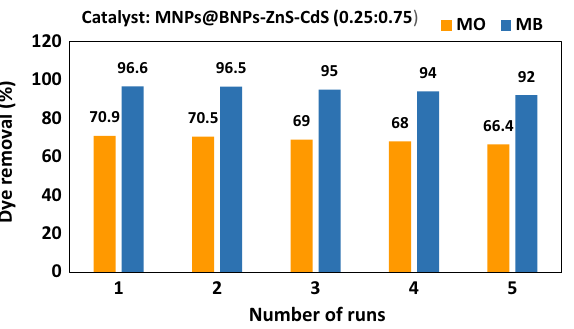
Figure 12. The renewability of Fe 3 O 4 @BNPs@ZnS-CdS for elimination of MB and MO.